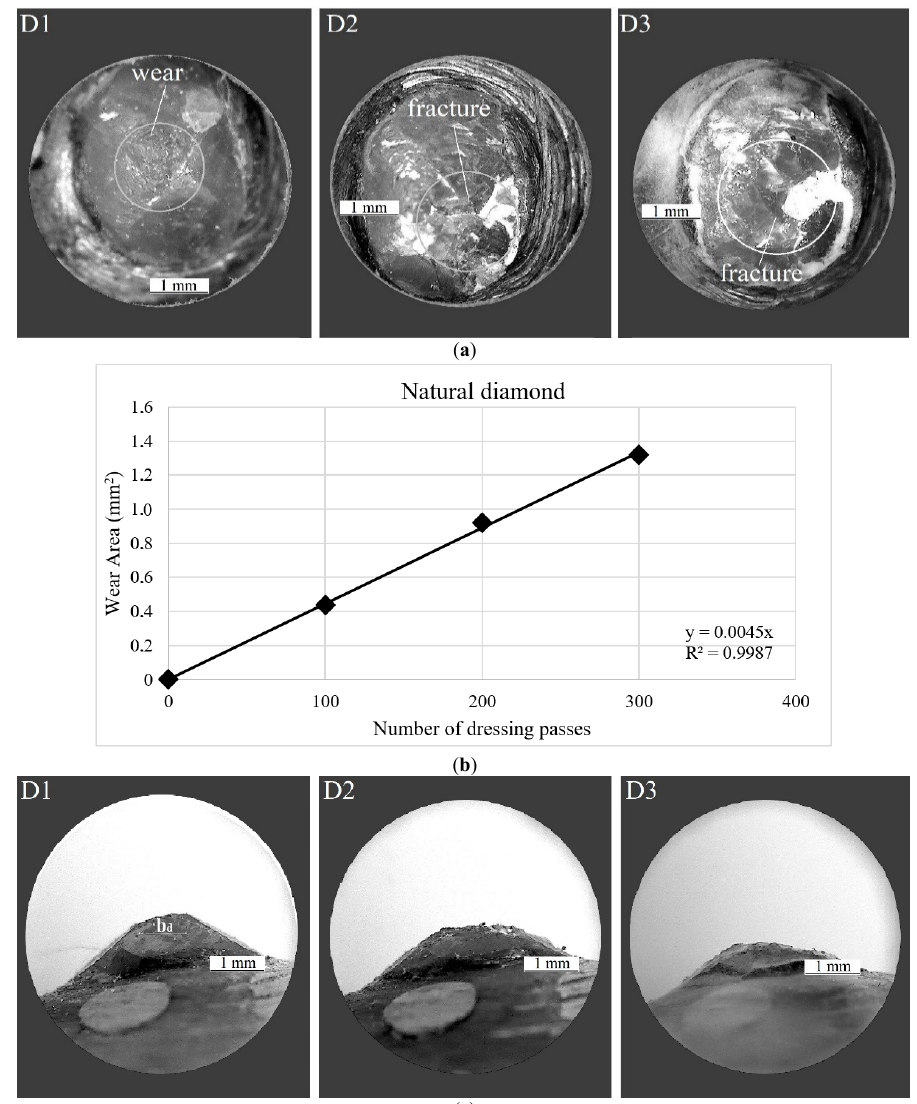
Figure 7. Analysis of the natural diamond wear state: ( a ) top view; ( b ) wear area trend; and ( c ) side